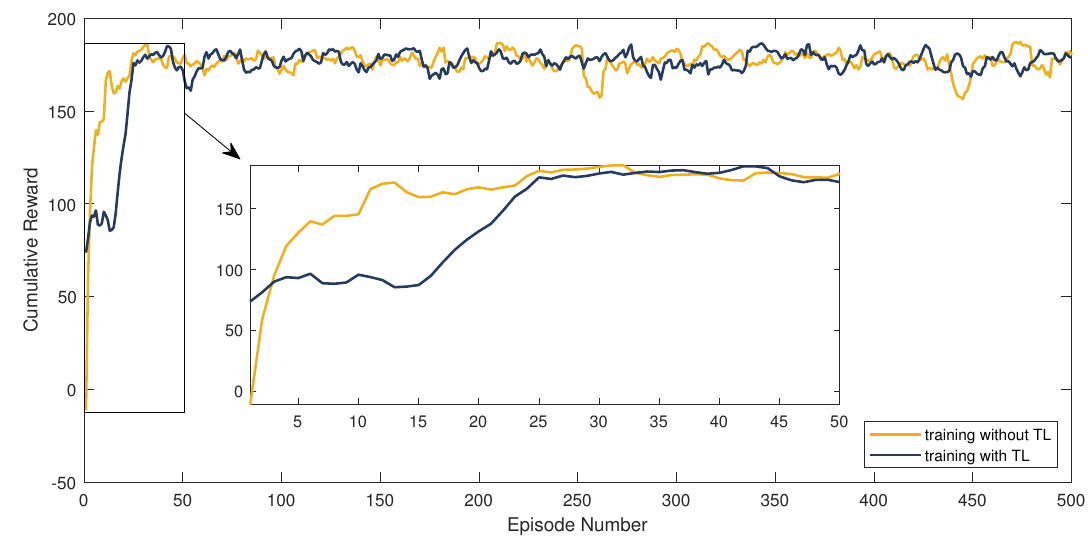
Figure 5. Comparison of the SARSA agent’s learning progress over 500 training episodes for training with and without pre-learning with the hysteresis controller’s strategy.